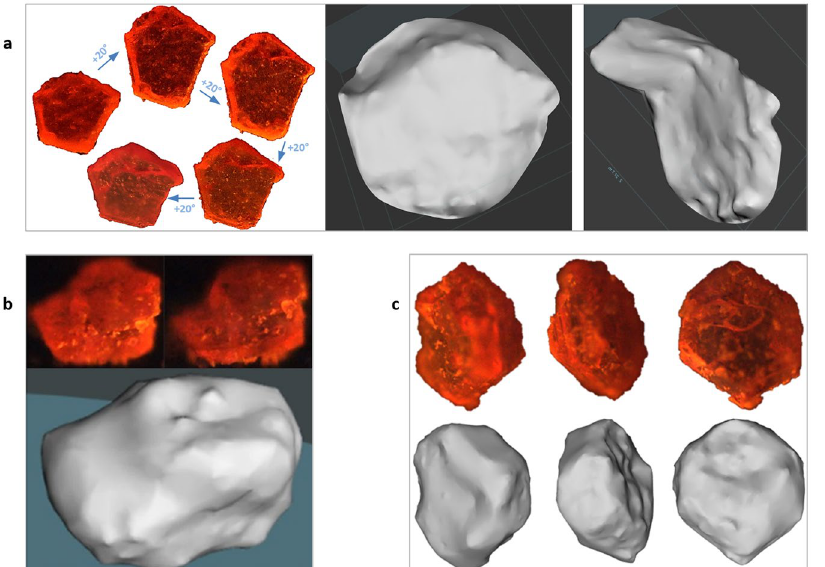
Figure 5. Full 3D-360° digital reconstruction of a single micro-particle. [Ru(bpy) 3 ]Cl 2 crystals were imaged in the dark as in Fig. 1, right, to allow auto-illumination by phosphorescence. ( a ) Ultra-thin solid flake (length: 540 µ m). Left ( a ): Real images from − 40° to + 40°. Right ( a ): Views from top and side of the digital surface reconstruction. ( b ) Real images (top) of a second particle (285 µ m) and the digital 3D model (bottom). ( c ) Real images (top) of a third particle (440 µ m) and the digital 3D model